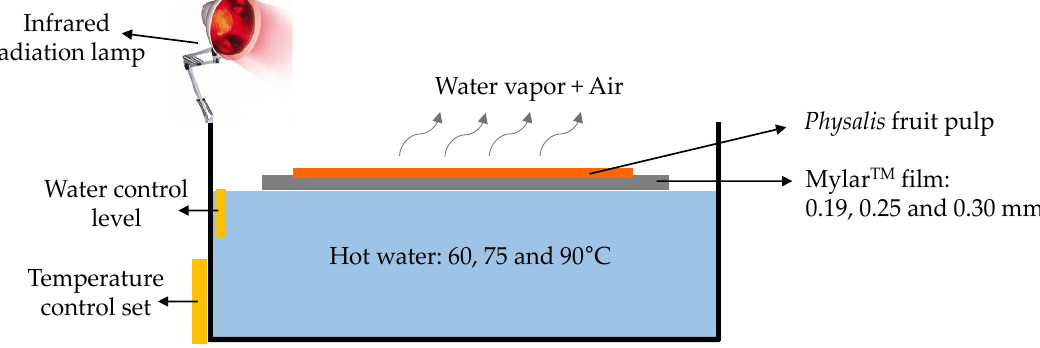
Figure 1. Experimental setup for infrared (IR)-assisted Refractance Window™ (RW ™) drying experiments.